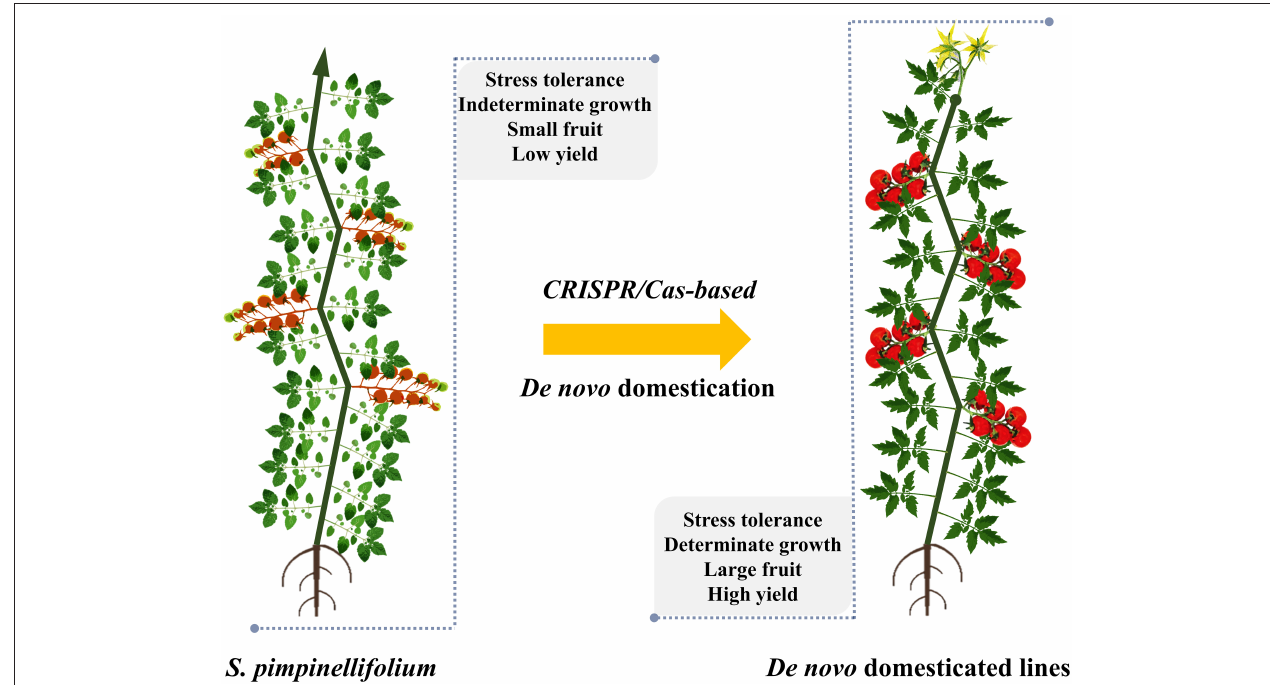
FIGURE 3 | De novo domestication of S. pimpinellifolium by CRISPR/Cas technology. A representative S. pimpinellifolium plant and its de novo domesticated form are shown, and the CRISPR/Cas-mediated domesticated traits are indicated. The plants are not drawn to